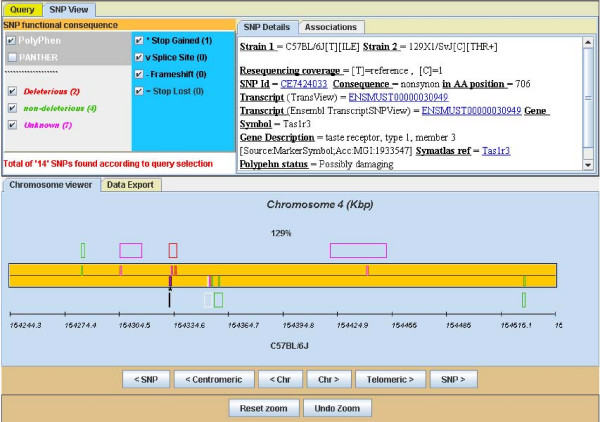
Web-based access to Mouse SNP Miner database. (not shown) 'SNP Query' mode allows selection of strain or strain group for comparison. Searching can be constrained by chromosomal interval, gene name, SNP accession number, and presence of human ortholog in OMIM database. QTL from the MGI database can be searched by name or keyword and associated chromosome intervals imported for convenient screening. (shown) 'SNP View' mode presents results from the search in a graphical format for convenient run-time scanning. SNPs in the interval are listed by functional consequence and PolyPhen/PANTHER prediction in the upper left and can be rapidly added or removed by clicking on the associated box. Boxes indicating transcripts and lines indicating SNPs are color and symbol coded by functional consequence in the graphical display. The placement of marks above and below the bar indicates transcripts in the forward and reverse strand, respectively. Clicking on a SNP causes detailed SNP information to be displayed in the 'Details' window above. The 'Associations' window displays GO, OMIM, and PolyPhen/PANTHER information and links for the selected SNP. Movement across the chromosome and between SNPs is facilitated by buttons at the bottom of the graphical display. In the example shown, a search has been performed for putative functional SNPs differing between C57BL/6J and all 129 strains (129% allows global searching of 129 strains) for the interval 153,482,802–154,678,264 bp on chromosome 4. A deleterious mutation (Ile706Thr) in the fourth transmembrane domain of Tas1r3 is highlighted.